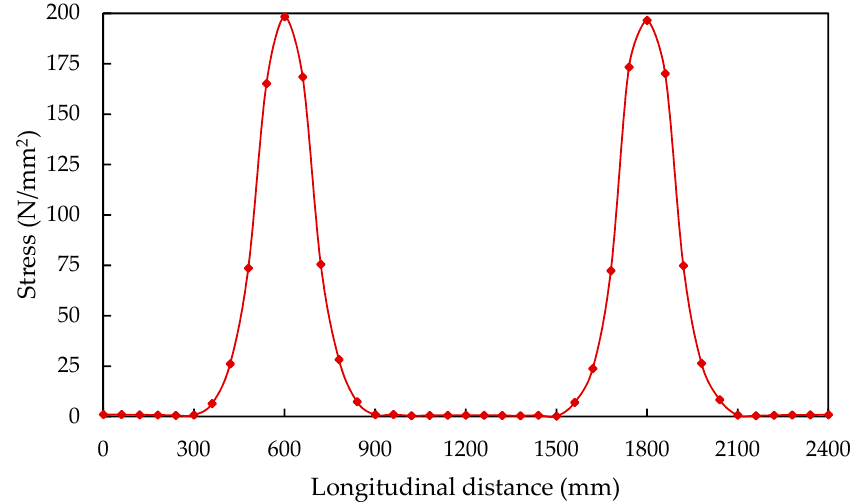
Figure 9. Stress variation in the longitudinal steel bar.